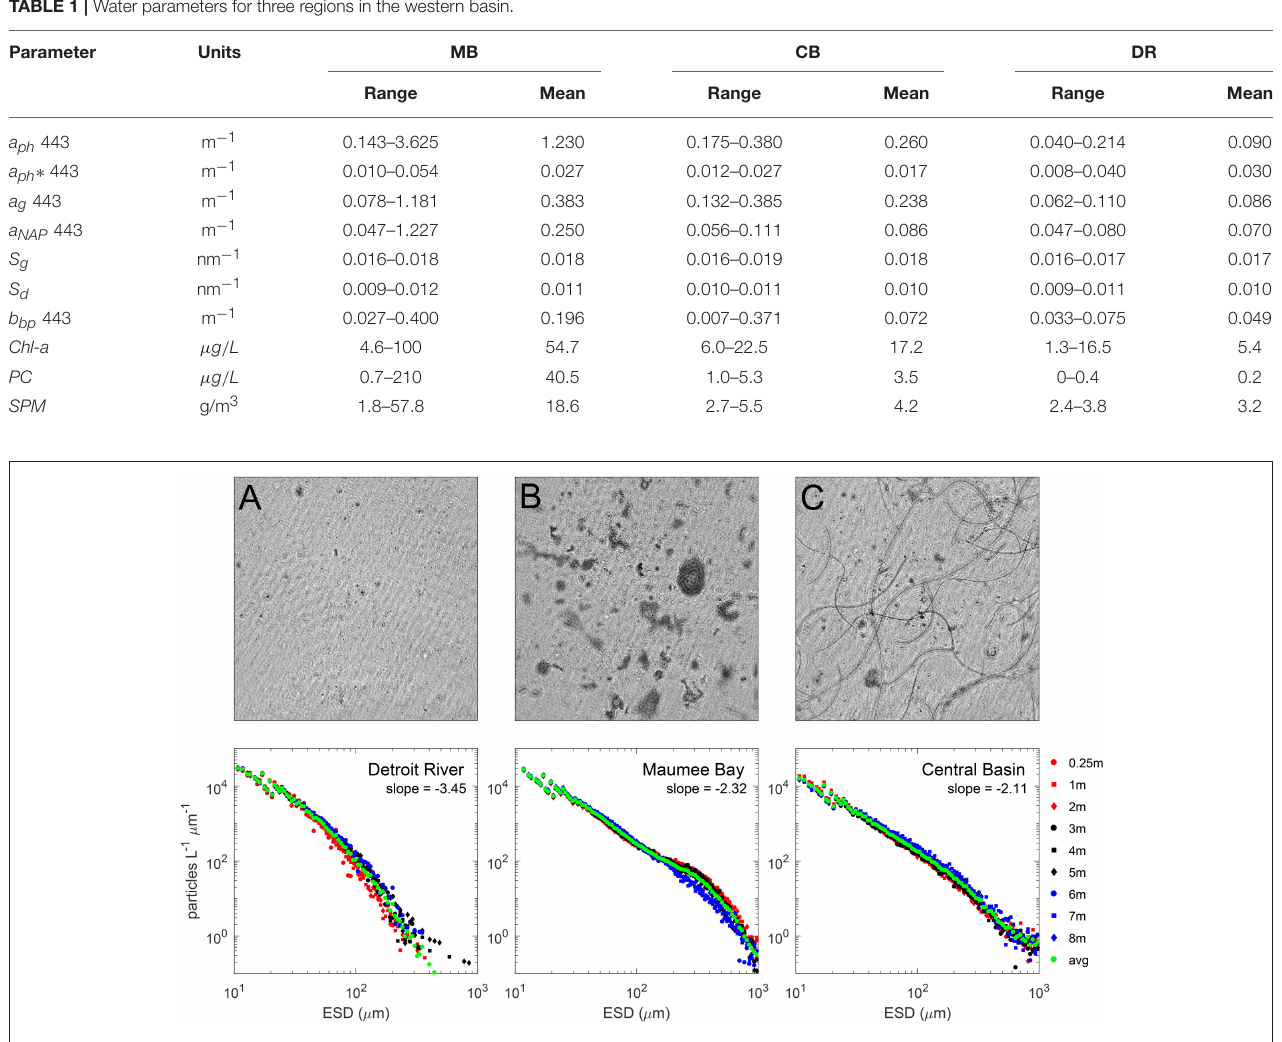
FIGURE 3 | Top row: Holographic composite images of the in situ phytoplankton populations in the Detroit River (A) , Maumee Bay waters (B) and southeast of Kelleys Island in the Central Basin (C) during 2014. The composite images are 2-D representations of all particles/phytoplankton in the 3-D holographic image volume. Each image is 7 × 7mm through a depth of 40mm (volume ∼ 2mL). Images were constructed with the background average subtracted to enhance particle clarity. The Detroit River waters were dominated by small inorganic particles and flagellates. The Maumee Bay waters were dominated by globular Microcystis colonies and the waters around the Islands were dominated by hair-like Planktothrix cells. Bottom row: Particle size distributions averaged for surface waters for each image. Slopes describing the Junge distribution are higher for the DR, and lower (and equivalent) in the CB and